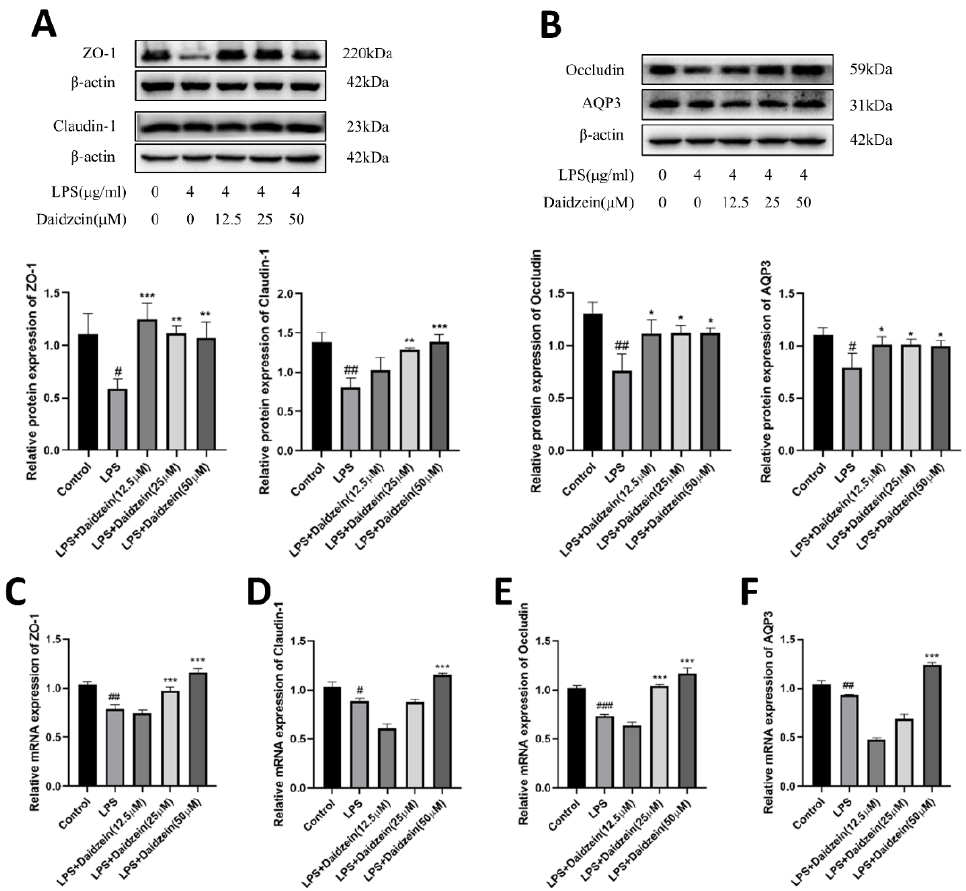
Figure 3. Daidzein increased lipopolysaccharide (LPS)-induced downregulated expression of tight junction and AQP3 proteins and mRNA. ( A ) The protein expression levels of ZO-1 and occludin and protein quantitative analysis. ( B ) The protein expression levels of claudin-1 and AQP3 and protein quantitative analysis. ( C – F ) The mRNA expression levels of ZO-1, occludin, claudin-1, and AQP3 (mean ± SD, n = 3), * p < 0.05, ** p < 0.01, and *** p < 0.001 versus LPS-treated alone. # p < 0.05, ## p < 0.01, and ### p < 0.001 versus